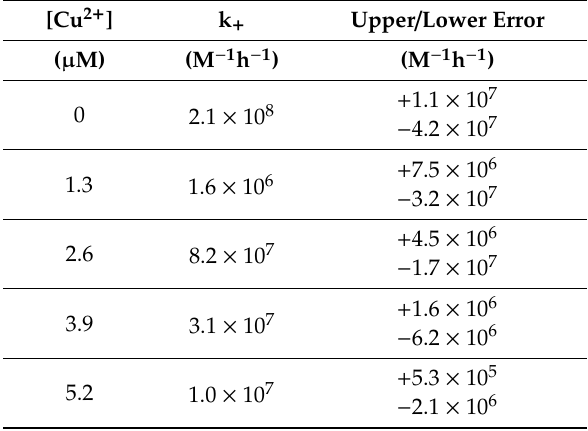
Table 1. Rate constants for A β (1-42) aggregation in the presence of Cu 2 + . Rate constants were determined by fitting the seeded kinetic data with k + as a dependent variable and k n and k 2 as globally fitted fixed parameters (e.g., elongation inhibition). The fitted values for k n and k 2 were interval in which the rate constant variation does not significantly changing the goodness of fit [85]. [Cu 2 + ] k